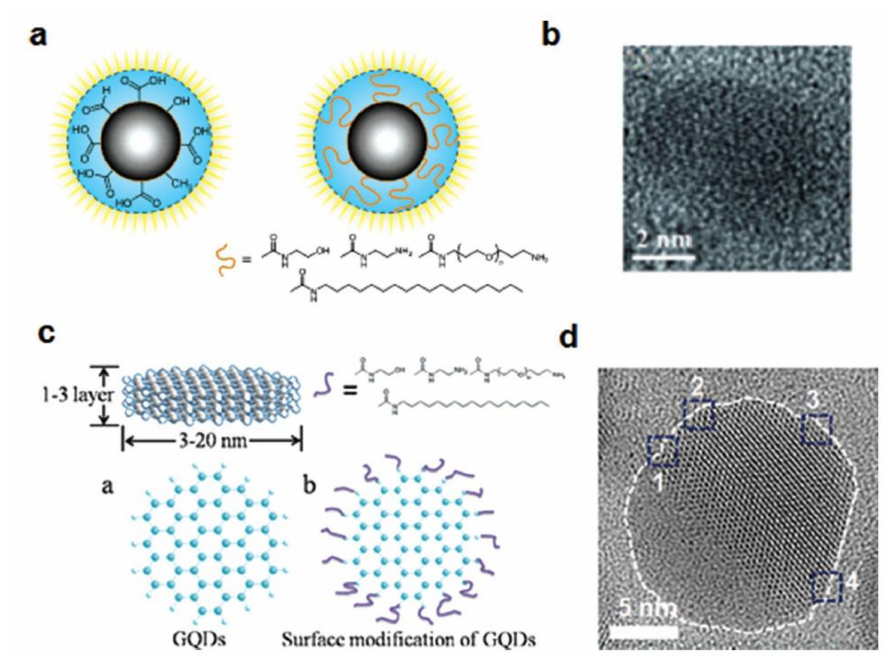
Figure 11. Structural depiction of ( a ) C-dots and ( c ) GQDs. HR-TEM images of ( b ) C-dots and ( d ) GQDs showing a combination of zigzag and armchair edges (positions marked as 1–4). Reprinted from [207] with permission of John Wiley and